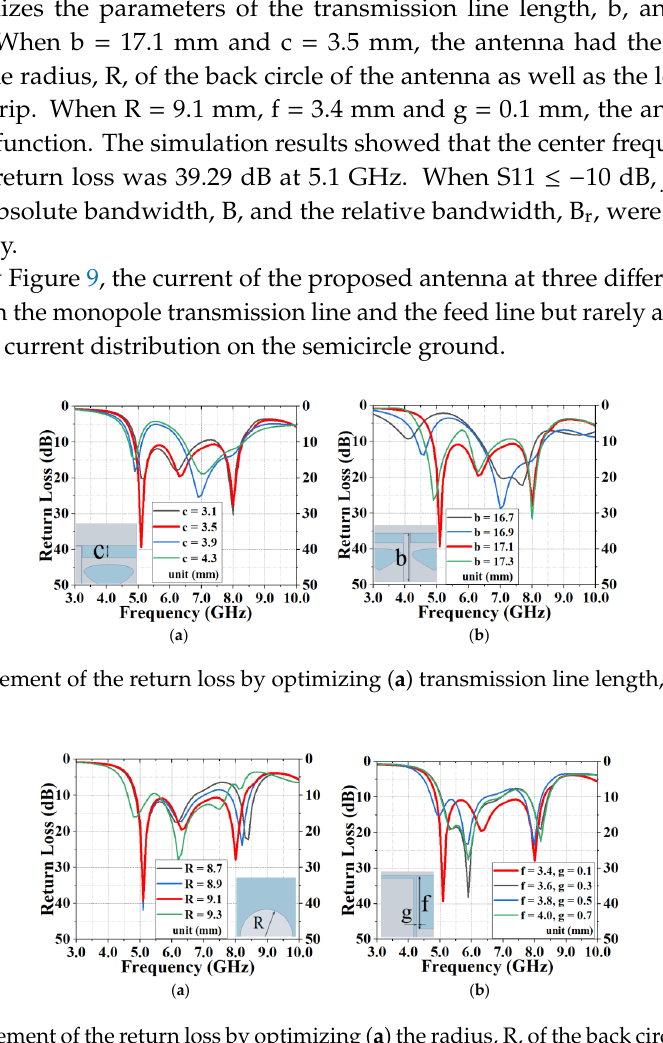
Figure 6. Symmetry analysis of the heart-shaped structure. Figure 7 optimizes the parameters of the transmission line length, b, and the T-slot width, c, of the antenna. When b = 17.1 mm and c = 3.5 mm, the antenna had the widest broadband. Figure 8